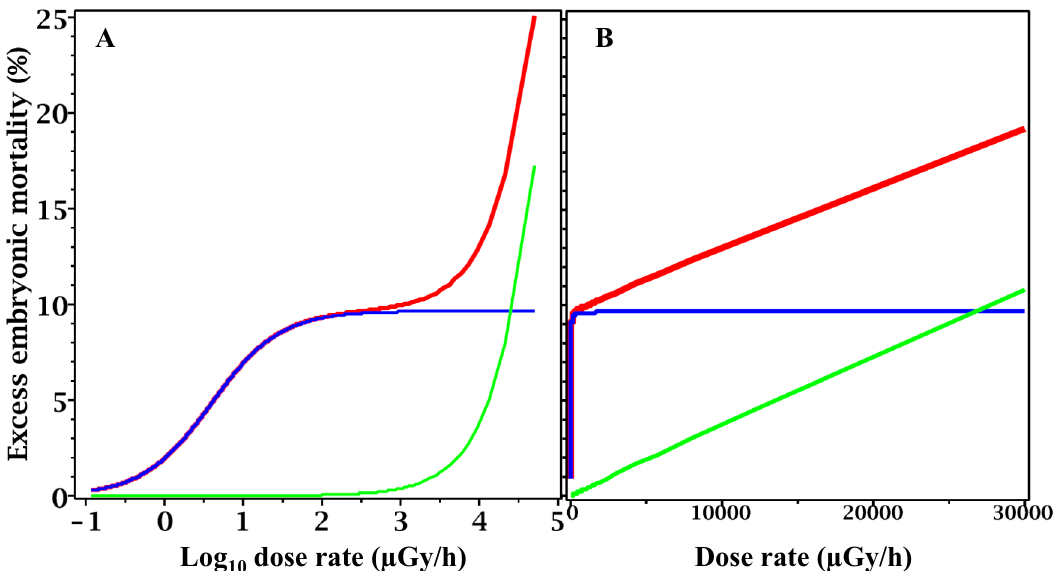
Figure 3. Predicted radiation responses at different constant dose rates based on best-fit model parameters for plant ( Arabidopsis thaliana ) data. ( A ) Dose rate shown on logarithmic scale for better visualization of low dose rates. ( B ) dose rate shown on linear scale. Red curve = total radiation response (TE and NTE). Blue curve = NTE only. Green curve = TE only. Time since the start of exposure to the constant dose rate was set to 20 years so that near-equilibrium for the response could be achieved. In this and the following figures, background embryonic mortality was subtracted for better visualization of the radiation responses.